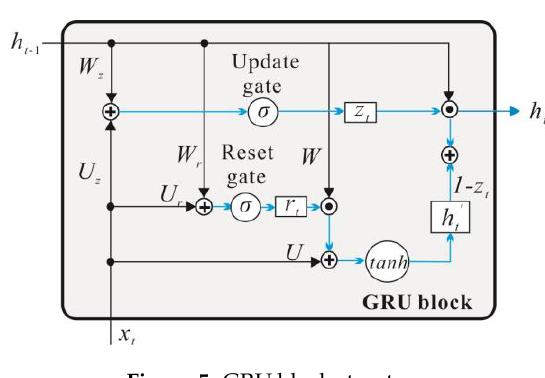
Figure 5. GRU block structure.